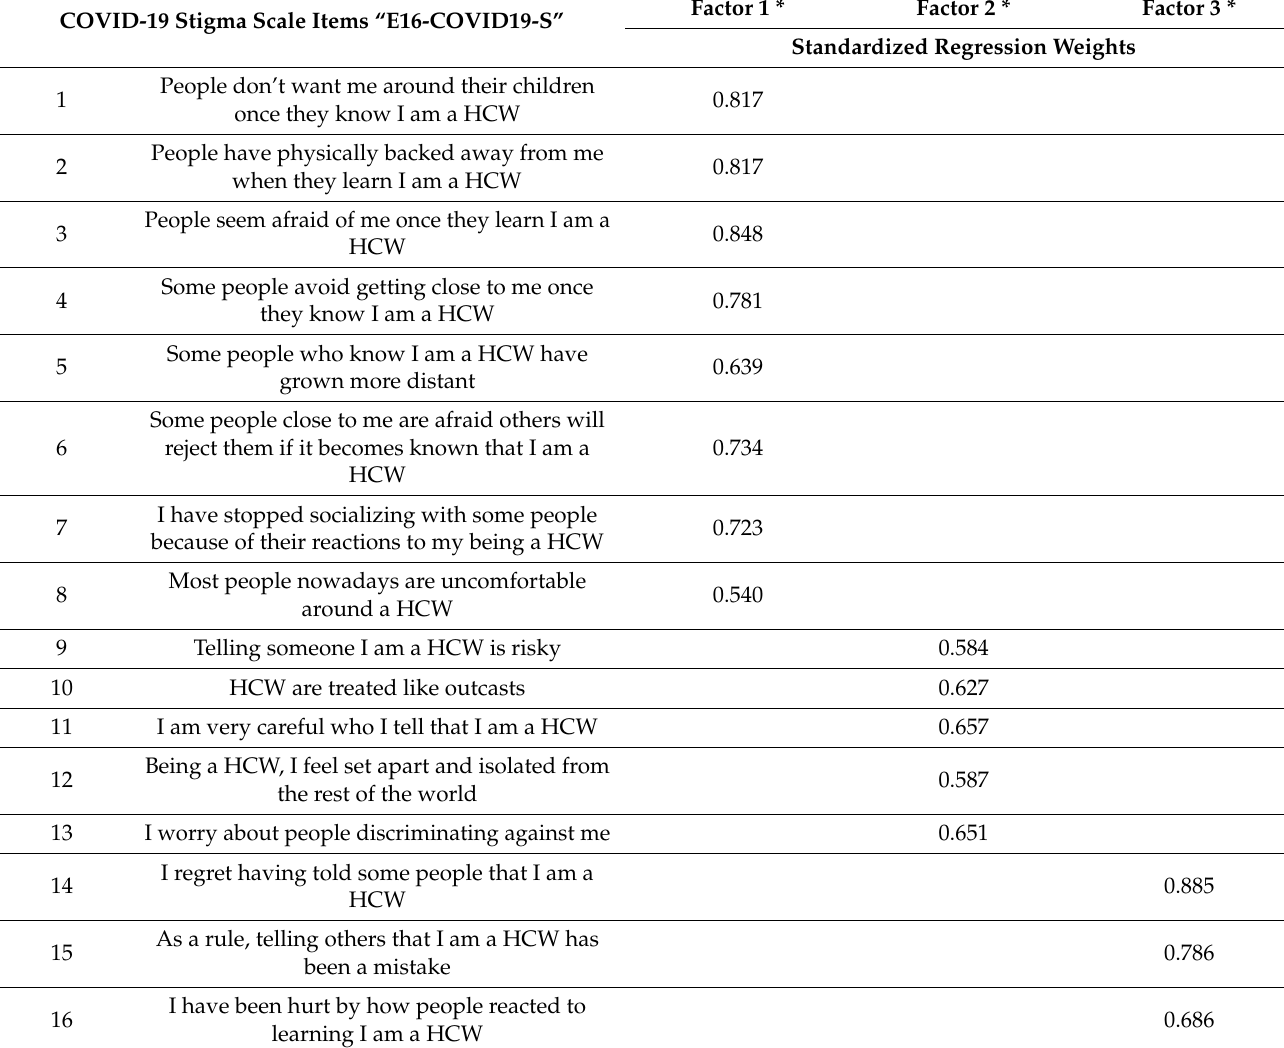
Table 3. Confirmatory factor analysis showing standardized regression weights of the 16 items constituting the adapted COVID-19 stigma scale “E16-COVID19-S” among the second half of the sample of Egyptian physicians (n = 251). Factor 1 * Factor 2 * Factor 3 * COVID-19 Stigma Scale Items “E16-COVID19-S” Standardized Regression Weights